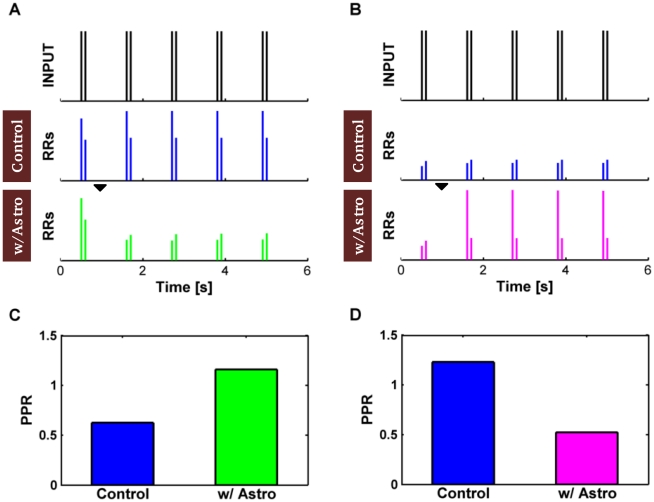
Astrocytic glutamate modifies paired-pulse plasticity.(A) A depressing and (B) a facilitating synapse are stimulated by a sequence of spike pairs (ISI = 100 ms) at 1 Hz (top) and the released resources (RRs) in absence (“Control”, middle) vs. in presence of the astrocyte (bottom) are monitored. The amount of resources released by spike pairs dramatically changes in presence of glutamate exocytosis from the astrocyte (black mark at t = 1 s, bottom). This behavior evidences a change of paired-pulse plasticity at these synapses which is summarized by the histograms in (C,D). The release-decreasing astrocyte (i.e. α = 0) on the depressing synapse in (A) remarkably increases the average synaptic paired-pulse ratio (PPR) (C), while the release-increasing astrocyte (i.e. α = 1) on the facilitating synapse in (B) decreases the PPR (D), which marks the onset of stronger paired-pulse depression. Parameters as in Table S1.